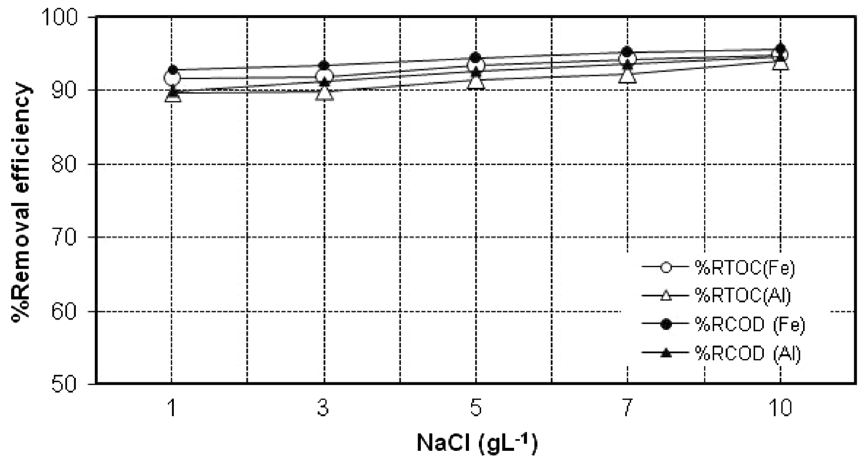
Fig. 2 The effect of NaCl con- centration on the COD and TOC removal by Fe and Al electrode ( i = 1.6129 mA/cm 2 ; t = 1 min; C o,COD = 399,800 mg/L; C o,TOC = 98,120 mg/L; T = 298 K; agitation speed = 120 rpm; pH